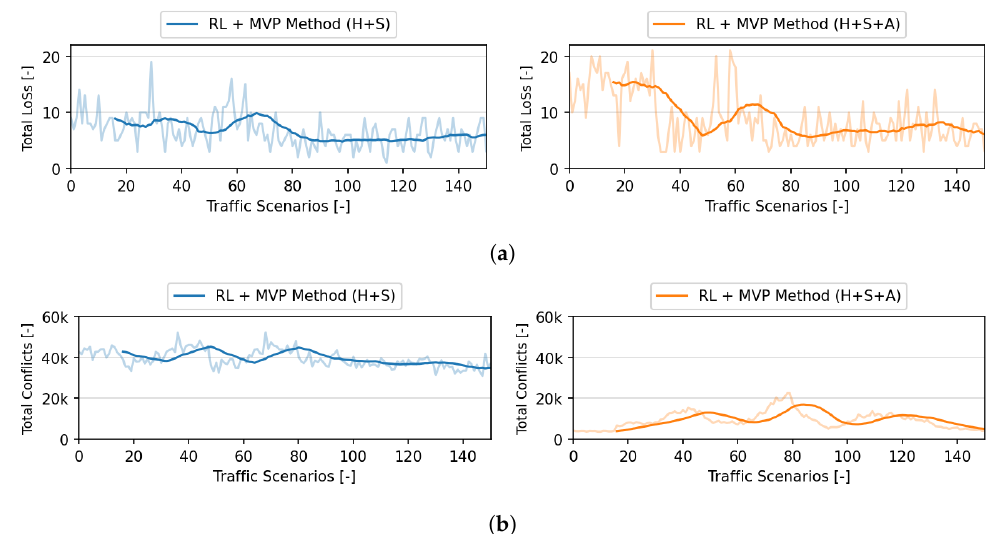
Figure 4. Evolution of the hybrid RL + MVP method during training. ( a ) Total number of LoSs during training of the RL + MVP method. ( b ) Total number of pairwise conflicts during training of the RL + MVP